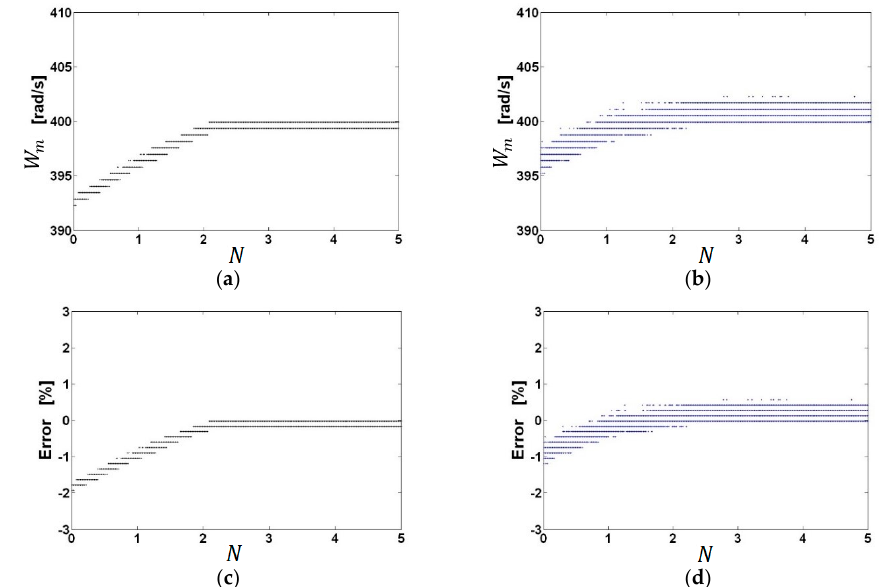
Figure 14. Bifurcation diagrams for the simulation and experimental test of the system with ZAD ( K S 3 = 35) and FPIC, changing the parameter N with K S 1 = K S 2 = 2 and a 2T delay period: ( a ) W m vs. N for the simulation test; ( b ) W m vs. N for the experimental test; ( c ) error vs. N for the simulation test; and ( d ) error vs. N for the experimental